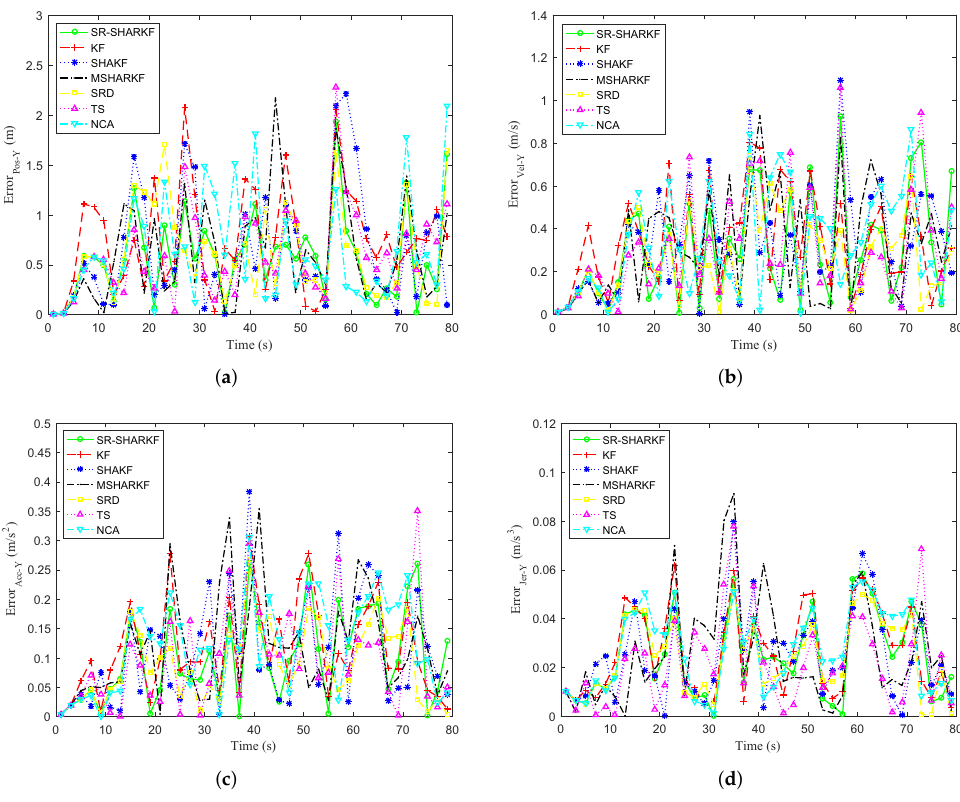
Figure 4. Dynamic parameter error in the X-axis direction. ( a ) Position error. ( b ) Velocity error. ( c ) Acceleration error. ( d ) Jerk error.